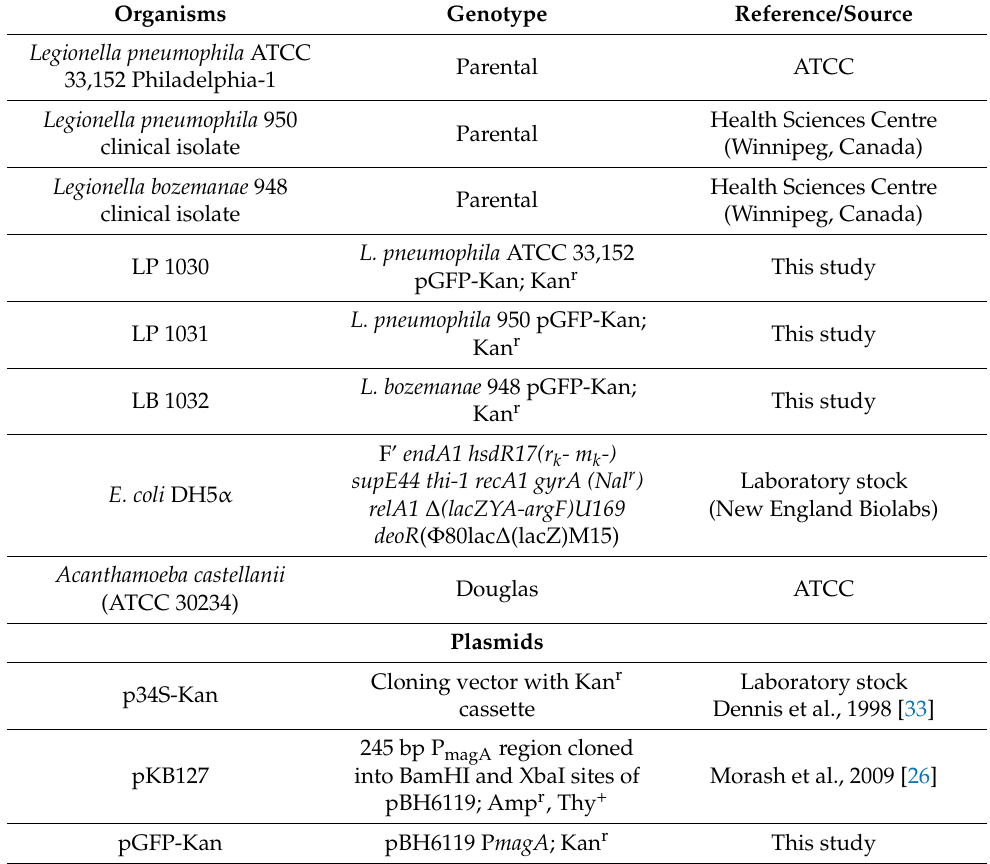
Table 1. Organisms and plasmids used in this study. Organisms